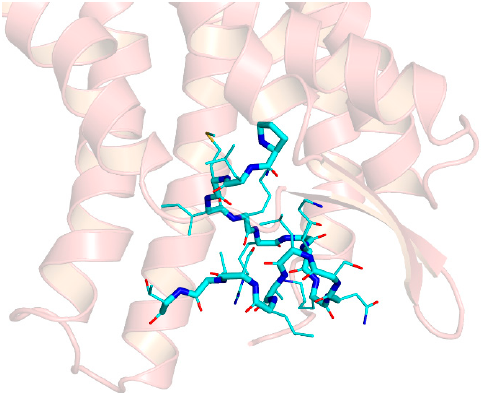
Figure 9. Model of binding of the peptide ER α 17p (cyan) to the extracellular region of GPER. The GPER is shown as semi-transparent (ribbon), with the disordered region 1–50 omitted. Hydrogen atoms are omitted in all panels. Side chains are represented as smaller sticks compared to the main chain, with the exception of the ring of the N-terminal proline. The oxygen and nitrogen atoms of the ligands are specified in red and blue, respectively. The N-terminus of the peptide is inserted in the protein core, in a configuration with the first proline residues slightly more plunged within the protein core, whereas the C-terminus is at the entrance of the protein